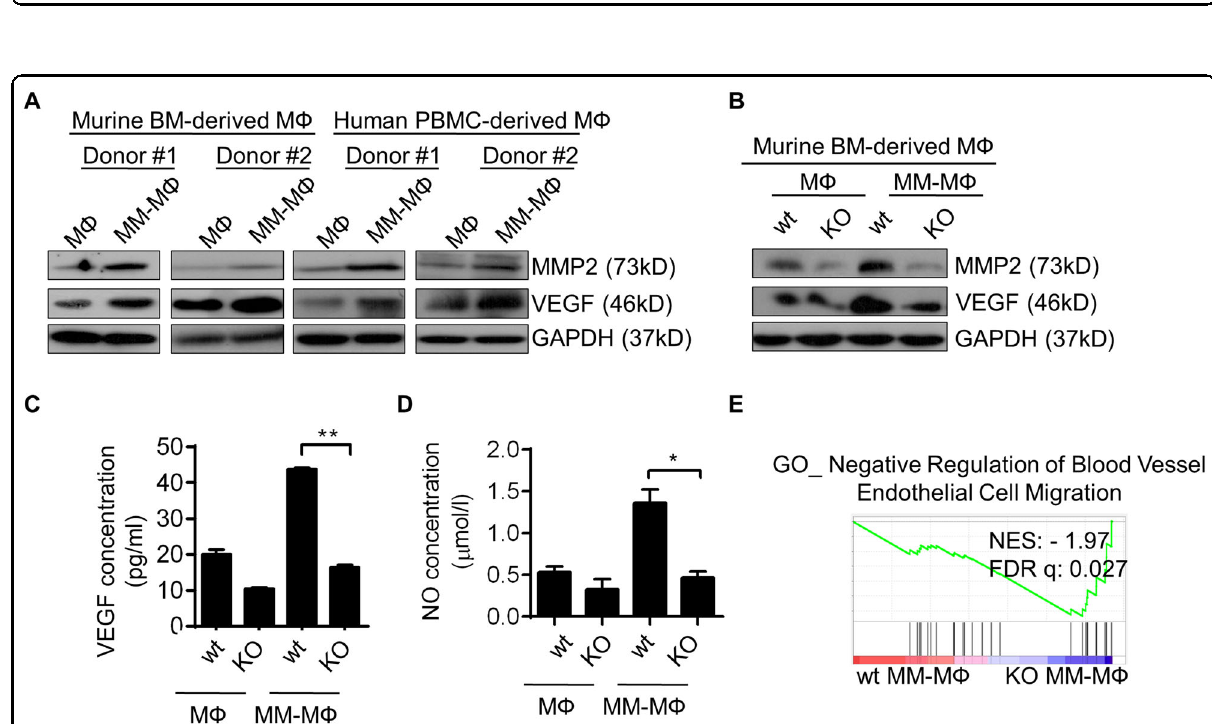
Fig. 5 BMI1 regulates pro-angiogenic function of MM-M Φ s. A Western blot showed the increased expression of MMP2 and VEGF in MM-M Φ s derived from both mice and human, relative to M Φ s. B Western blot showed that knockout of BMI1 impaired the expression of MMP2 and VEGF in MM-M Φ s. C ELISA assay detected the concentration of VEGF in culture supernatant of murine BM-derived M Ф s and MM-M Ф s from wt or BMI1-KO mice. Statistical signi fi cance was determined by two-tailed Student t -test between wt and BMI1-KO MM-M Ф s, ** P < 0.01. D BMI1 knockout lowered the levels of NO in culture supernatant of MM-M Ф s. Statistical signi fi cance was determined by two-tailed Student t -test between wt and BMI1-KO MM-M Ф s, * P < 0.05. E GSEA of RNA-seq data showed the enrichment of genes negatively regulating blood vessel endothelial cell migration in BMI1- KO MM-M Ф